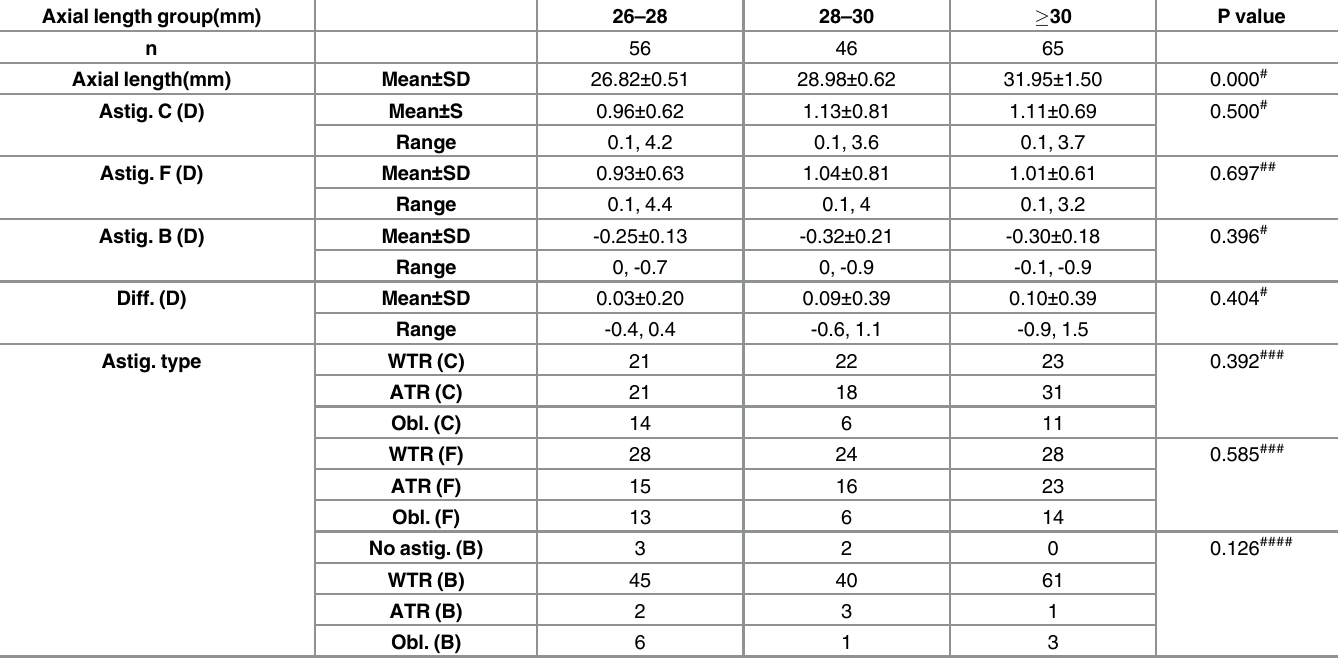
Table 3. Corneal characteristics of high myopia by axial length.